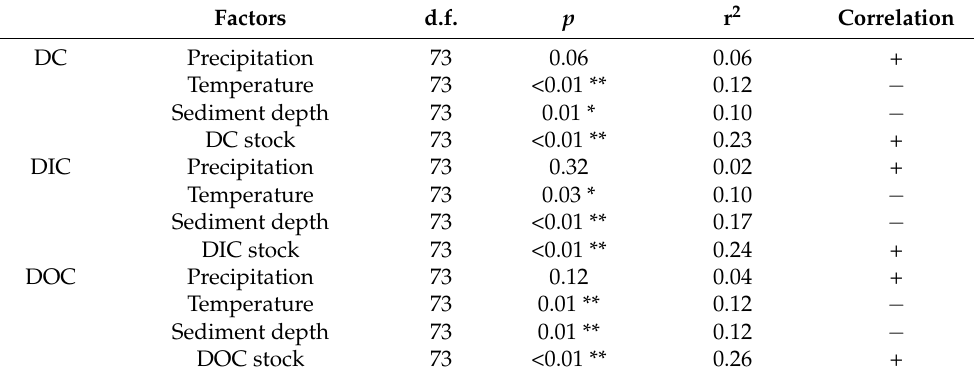
Table 3. Relationships between dissolved carbon (DC), dissolved inorganic carbon (DIC), and dissolved organic carbon (DOC) export and investigated stream characteristics in the investigation